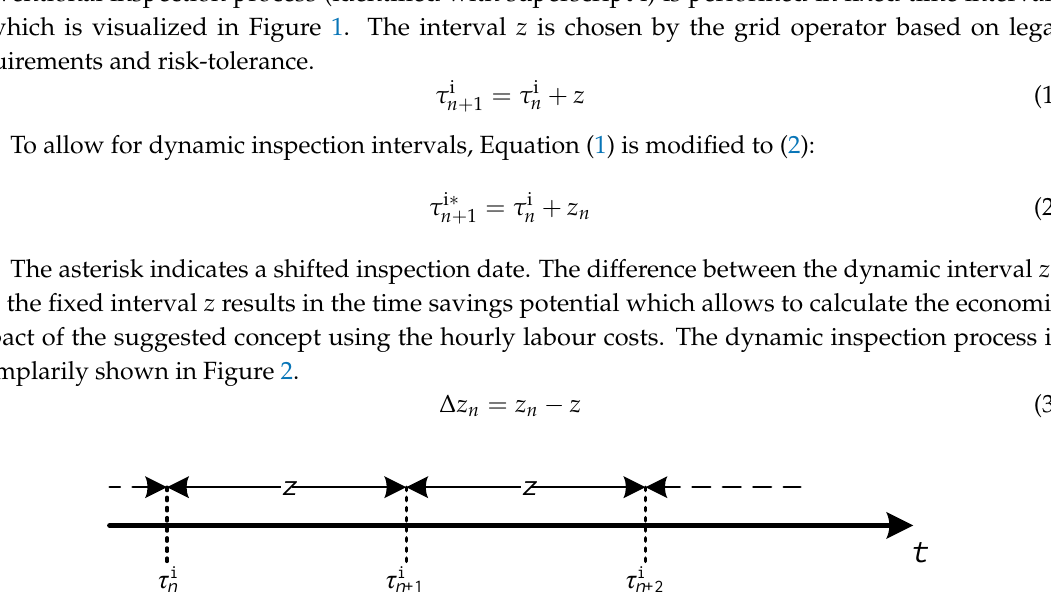
Figure 1. Classic inspection process with temporally constant